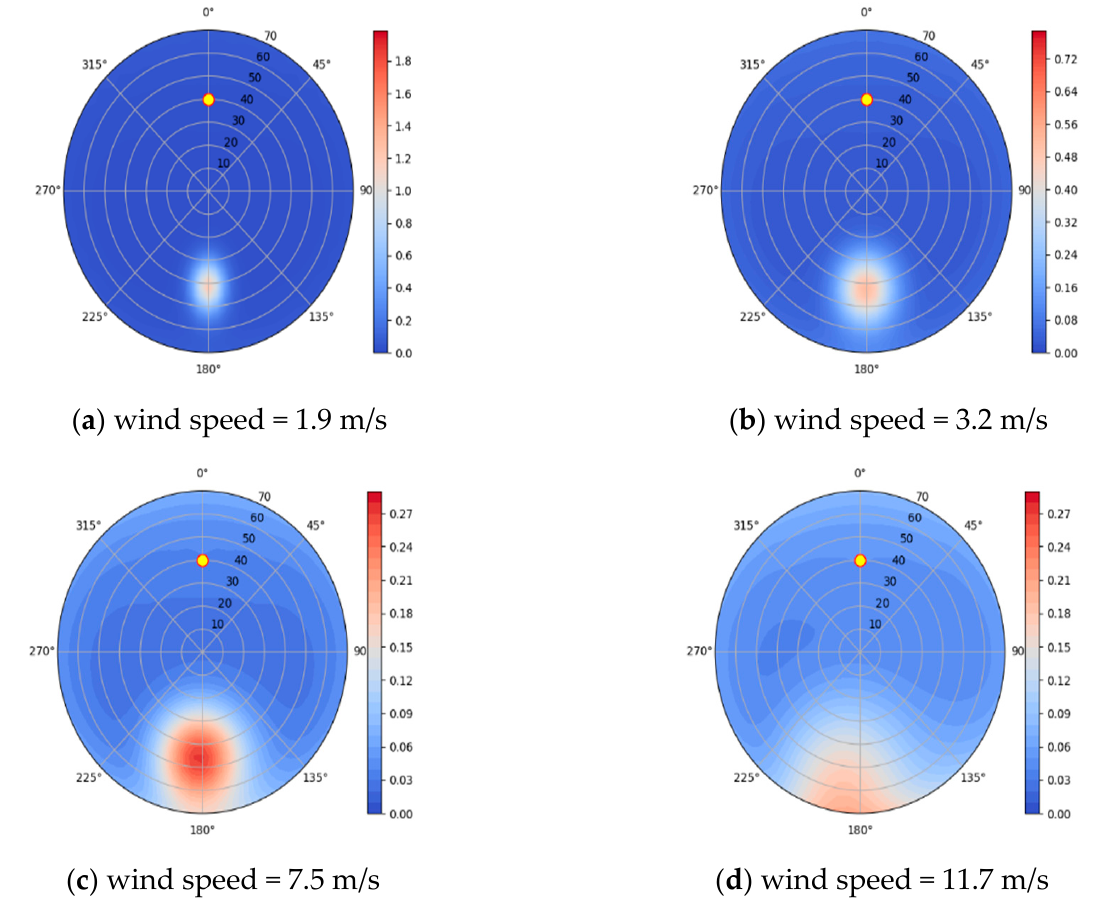
Figure 6. Bidirectional reflectance simulation of the ocean at the top of the atmosphere of the DPC (670 nm). Figure 7 shows that the radiometric deviation calculated by using desert and ocean sites shows significant non-uniformity varying with the view zenith angle. We used two fit curves for each visible band over the LNES and SENS to determine the deviation ratio at view zenith angles of 0 ◦ , 15 ◦ , 30 ◦ , 45 ◦ and 60 ◦ , and the results are listed in Table 4. For band 670, ∆ A = 0.9 for the central field (VZ = 0 ◦ ), and ∆ A = 0.97 for the edge (VZ = 60 ◦ ), which indicates a nearly 8% relative radiometric deviation on the sensor. For bands 443, 490 and 565, the differences in ∆ A from the central field to the edge are larger: about 9–16% for band 443, 11 to 17% for band 490 and 13–16% for band 565. The calibration results based on ocean and desert sites show similar distribution characteristics for ∆ A and ∆ B versus the view zenith angle. However, there are some deviations between the fit curves of these two calibration results, especially at view zenith angles larger than 45 ◦ for the blue band to the yellow band (443, 490, 565), which may be introduced in the spectral interpolation of the desert data as the spectra increase quickly with the wavelength in the region of 400–600 nm, which can be found in the other articles [11–13]. We finally recommend following the calibration results over an SNES in visible